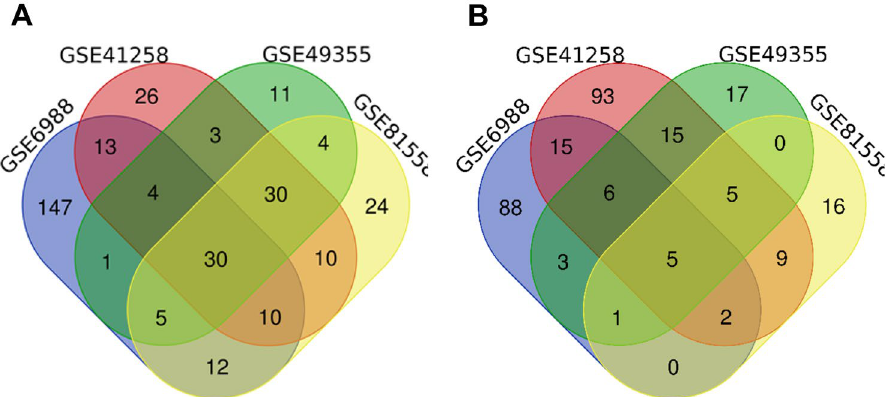
Figure 1. (SET 1) Venn diagram showed 35 DEGs distinguishing primary tumor tissues and metastasis tumor tissues in both GEO datasets. ( A ) 30 Upregulated genes ( B ). 5 Downregulated genes. DEG differentially expressed gene, GEO Gene Expression Omnibus.